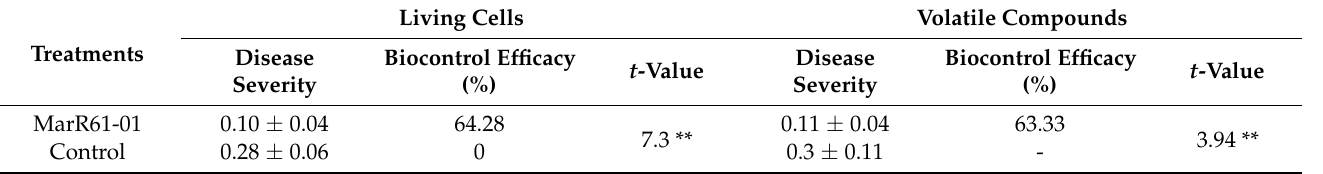
Table 4. Effects of Serratia rubidaea MarR61-01 on fruit decay caused by Botrytis cinerea assessed 5 days after treating fruits with the bacterial cells or volatile compounds produced by the bacterium. Biocontrol efficacy is expressed as reduction (%) of disease severity (% of fruit surface with gray mold symptoms) compared to untreated